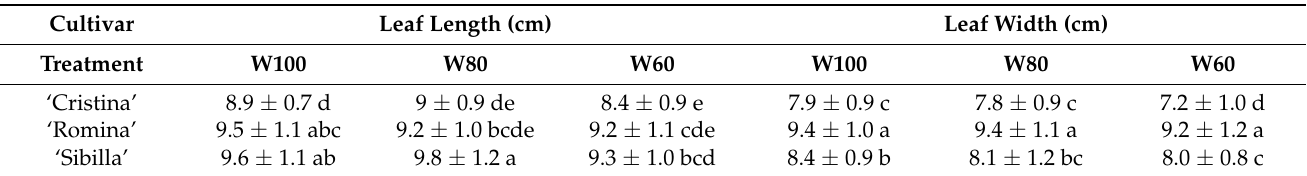
Table 7. Effects of water availability on development of leaves in different strawberry cultivars. Values with the same lowercase letter for the same parameter were not statistically different for Fisher’s LSD test ( p < 0.05). Values are expressed as means of two years (2017–2018) ± standard deviation (SD).